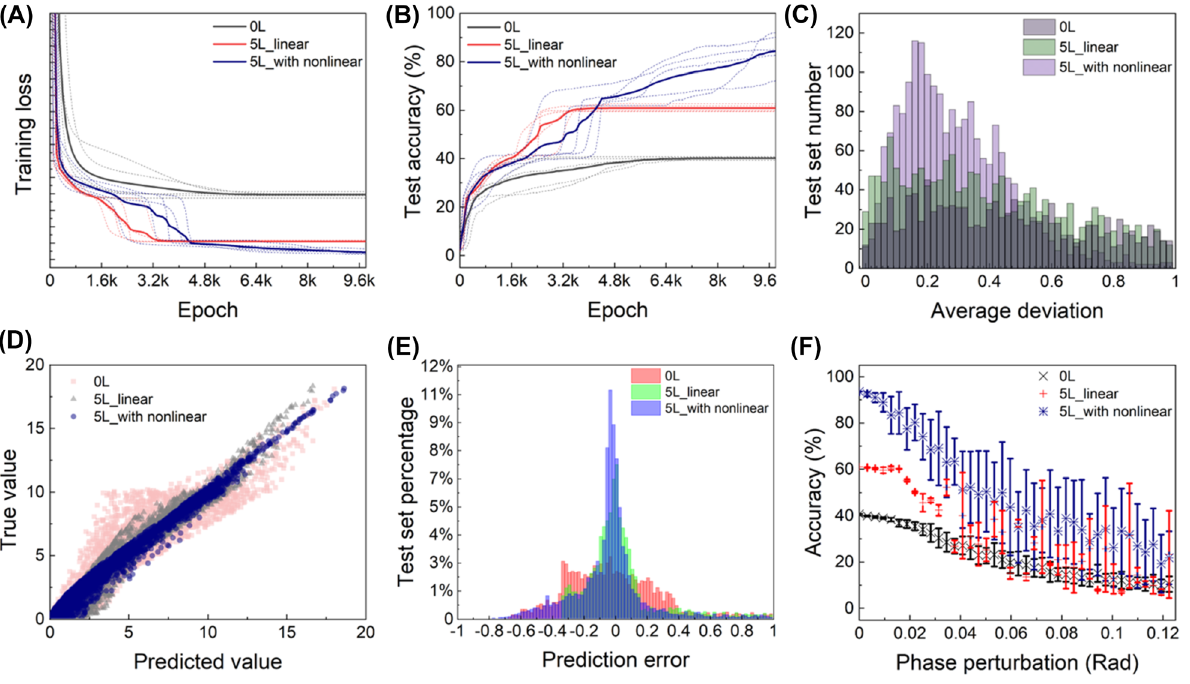
Figure 2: Performance of the 2 × 2 matrix eigenvalue solver. (A) Training loss reduction comparison among linear combination (0L), linear combination plus 5-layer structure (5L) and linear combination plus 5-layer structure with nonlinear activation function (5L with nonlinear). Solid linesrepresent average loss of 5 training attempts depicted by dotted lines. (B) Comparison of test set accuracy among the three configurations above, where solid lines represent average loss of 5 trainingattemptsdepictedbydottedlines.(C)Distributionoftheaveragetestdeviationofthethreeconfigurationsabove,whichiscutoffafter the deviation of 1. (D) Correlation between the true value and the predicted value for 0L, 5L, and 5L with nonlinear condition. (E) Relative deviation for 0L, 5L, and 5L with nonlinear condition. (F) Test accuracy reduction of the three configurations above under random phase perturbation on phase shifters. Error bar represents standard variance of 20 random